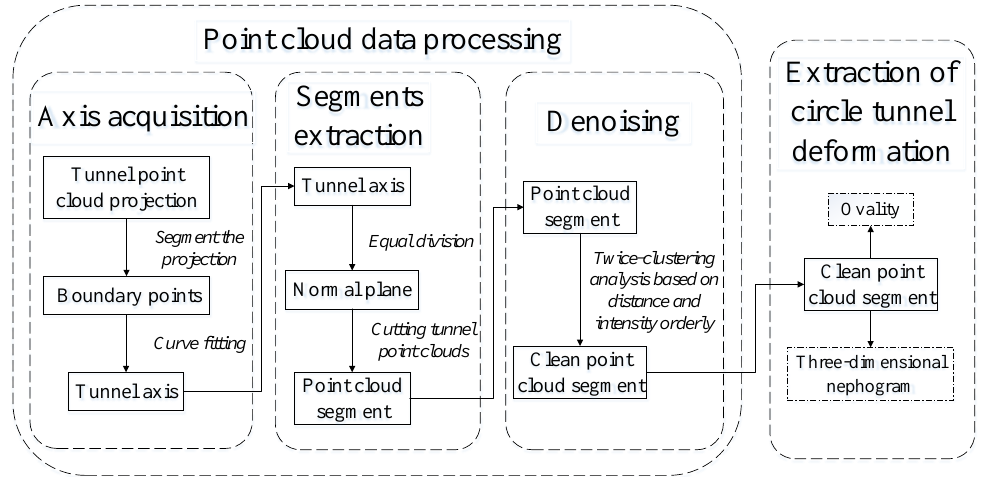
Figure 1. Flow chart of the proposed monitoring system.